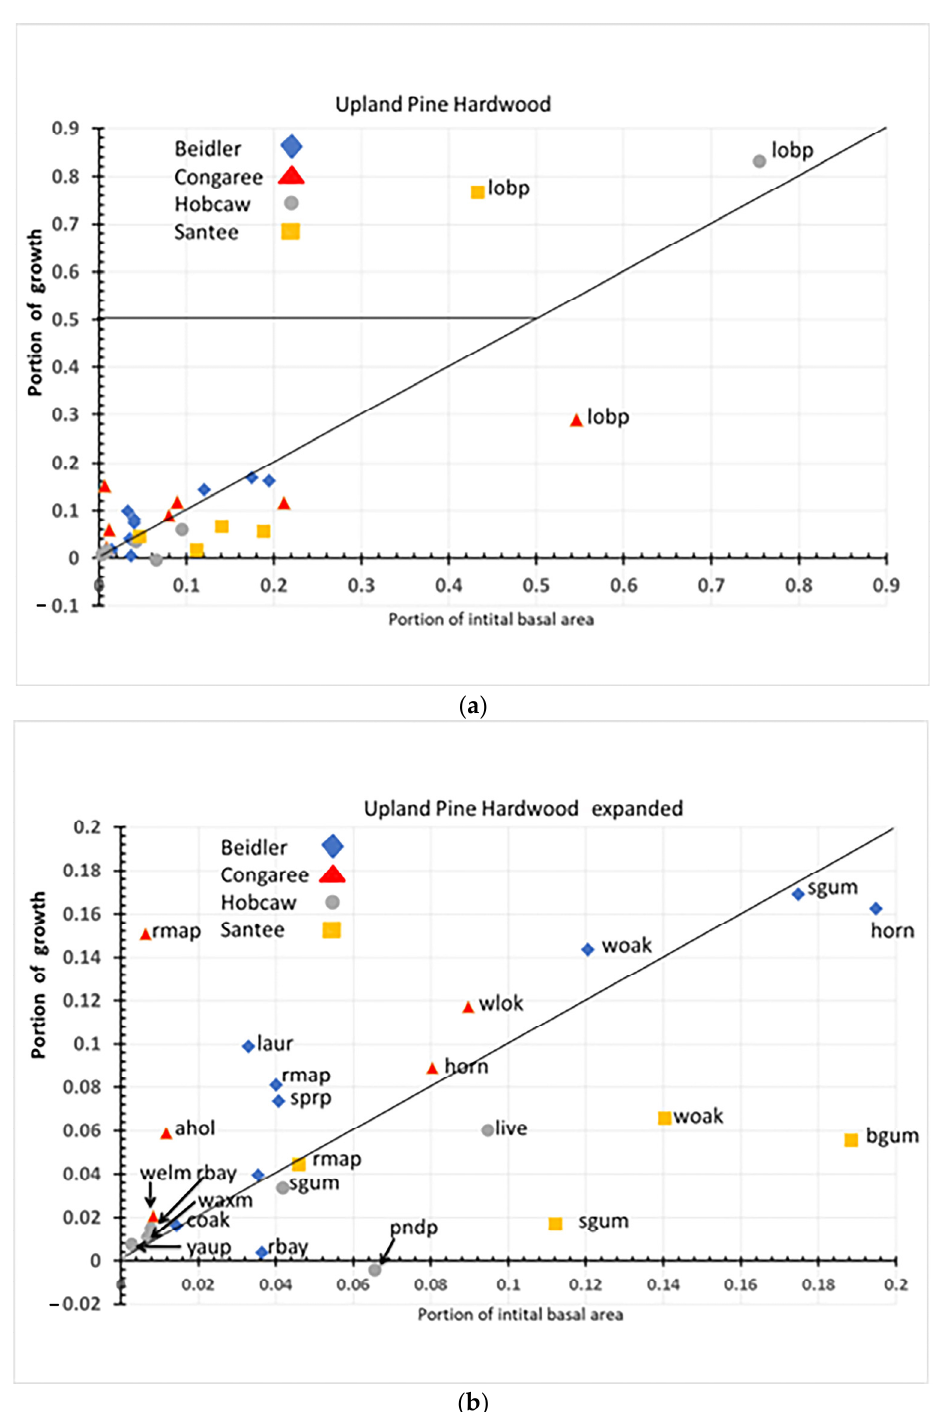
Figure 14. ( a ) Overall response of species in the upland pine hardwood type. Each species is labeled with 4 letter species code (Table 1) and site name. ( b ) Enlargement of section of ( a ) near the origin in order to separate species codes.